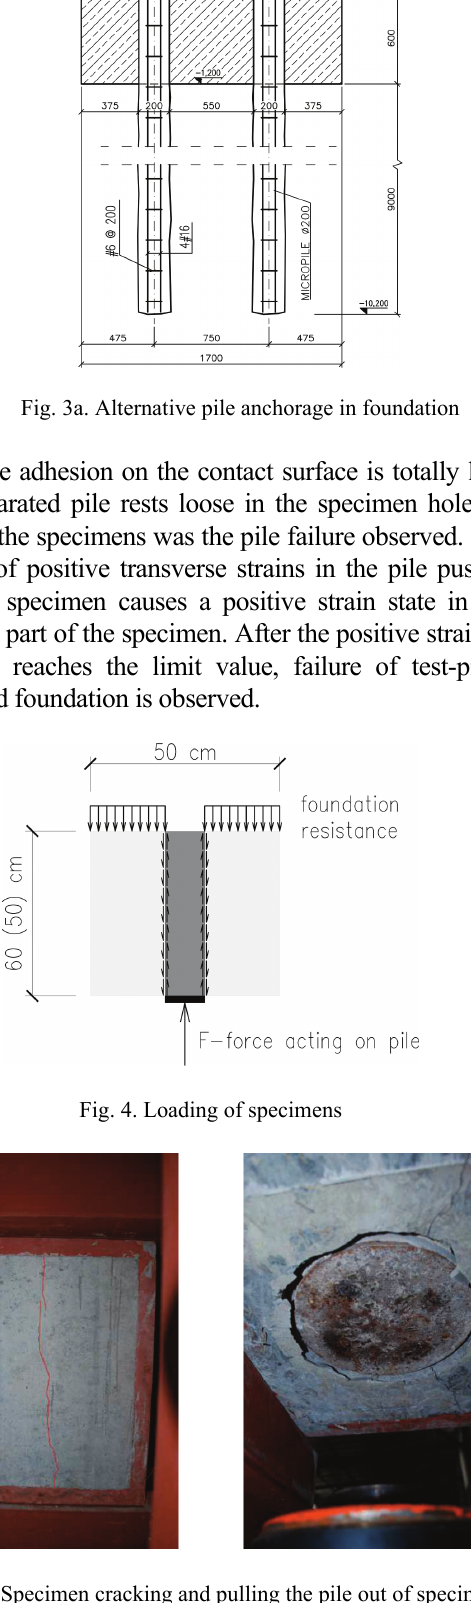
Photo 1. Specimen cracking and pulling the pile out of specimen